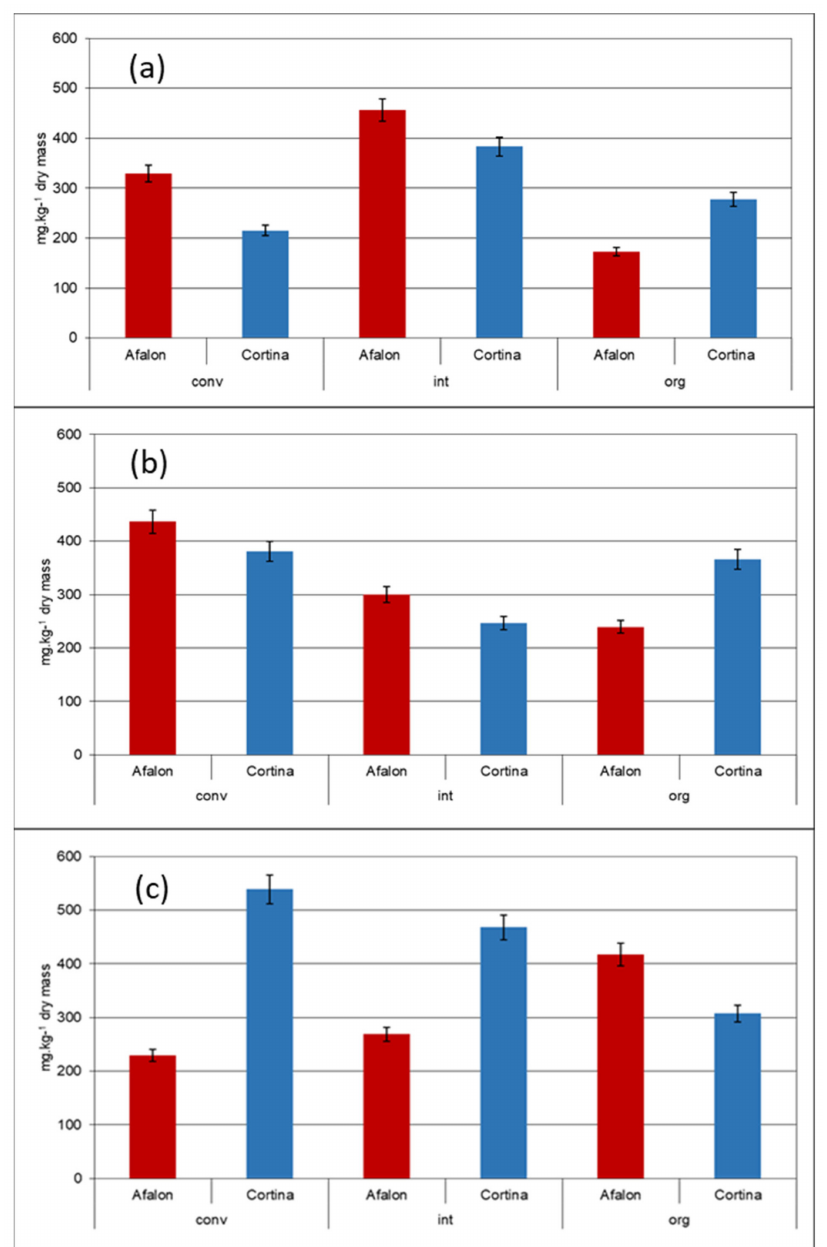
Figure 1. Comparison of AA content in Cortina (blue) and Afalon (red) grown in conventional (conv), integrated (int) and organic (org) systems: ( a ) crop year 2012, seeding density 9 × 10 5 seeds ha − 1 ; ( b ) crop year 2013, seeding density 6 × 10 5 seeds ha − 1 ; and ( c ) crop year 2013, seeding density 9 × 10 5 seeds ha − 1